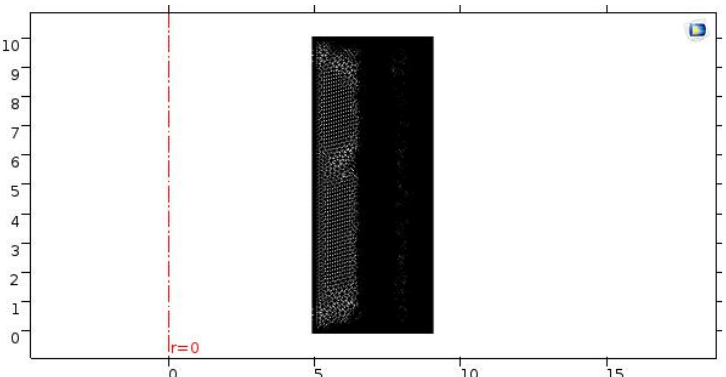
Fig. 3: Meshes created by COMSOL Multiphysics 5.2; Complete mesh consisted of